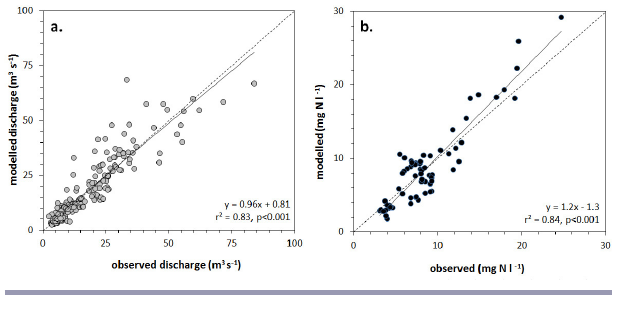
Fig. 4. Performance of the calibrated ExtendSim estuarine box model for the estuarine boxes along the Westerschelde after 1 yr of model run (2006). The intercept did not differ significantly from zero ( p = 0.21) and the slope is not significantly different from one ( p =